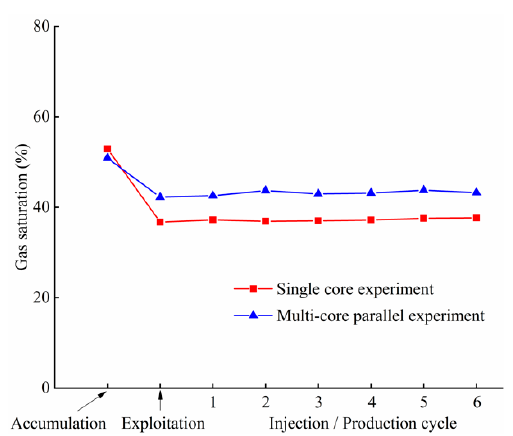
Figure 13. Variation curve of gas saturation with heterogeneous reservoir in the gas-water transition zone.